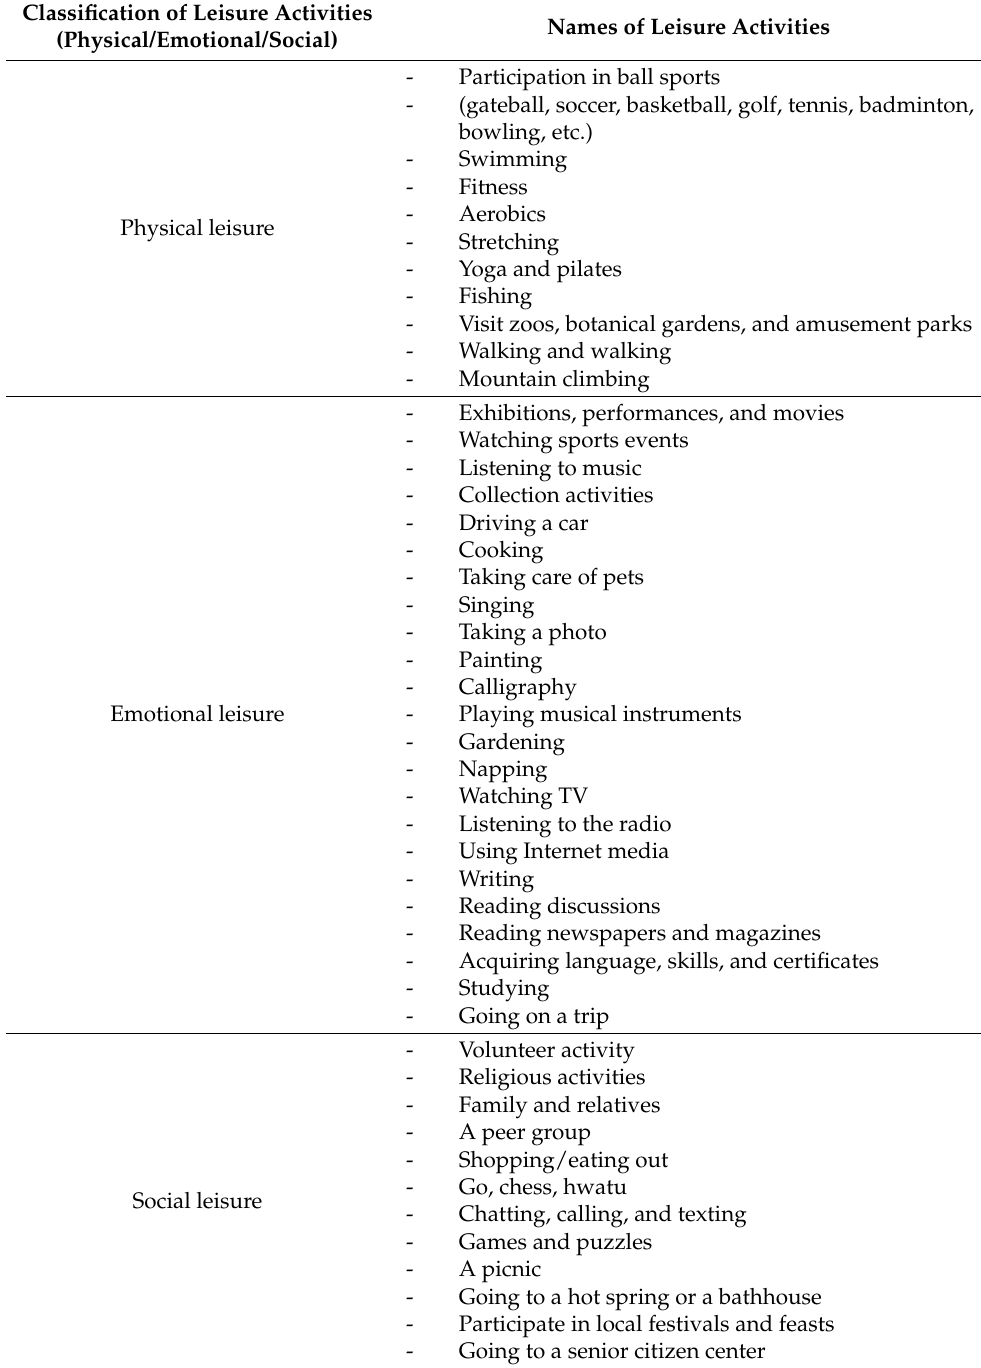
Table 5. The 45 participating in leisure activities items found through the National Leisure Activ- ity